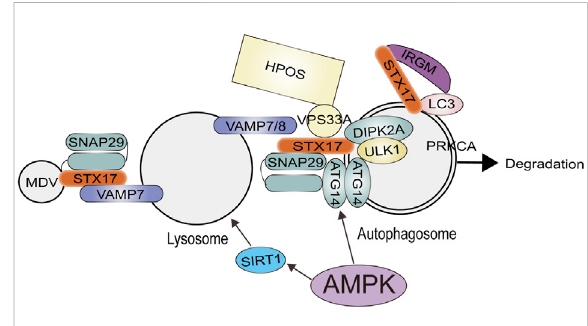
FIGURE 3 The role of AMPK for Autophagosome-lysosome fusion of autophagosomeswithlysosomesinvolvestheconcerted actionof RABs, tethers, and the SNARE complex. AMPK can positively regulate lysosomal biogenesis and function. AMPK activates ATG14 thereby promoting the fusion of the autophagosome and lysosome. Abbreviations: ATG14, autophagy-related protein14; DIPK2A, divergent protein kinase domain 2A; HOPS, homotypic fusion and protein sorting; IRGM, immunity related GTPase M; MDV, mitochondrial-derived vesicle; PRKCA, Protein Kinase C Alpha; SNAP29, synaptosomal associated protein 29; STX17, syntaxin 17; VAMP7, vesicle associated membrane protein seven; VPS33A,vacuolarproteinsorting33homologA;ULK1,unc-51